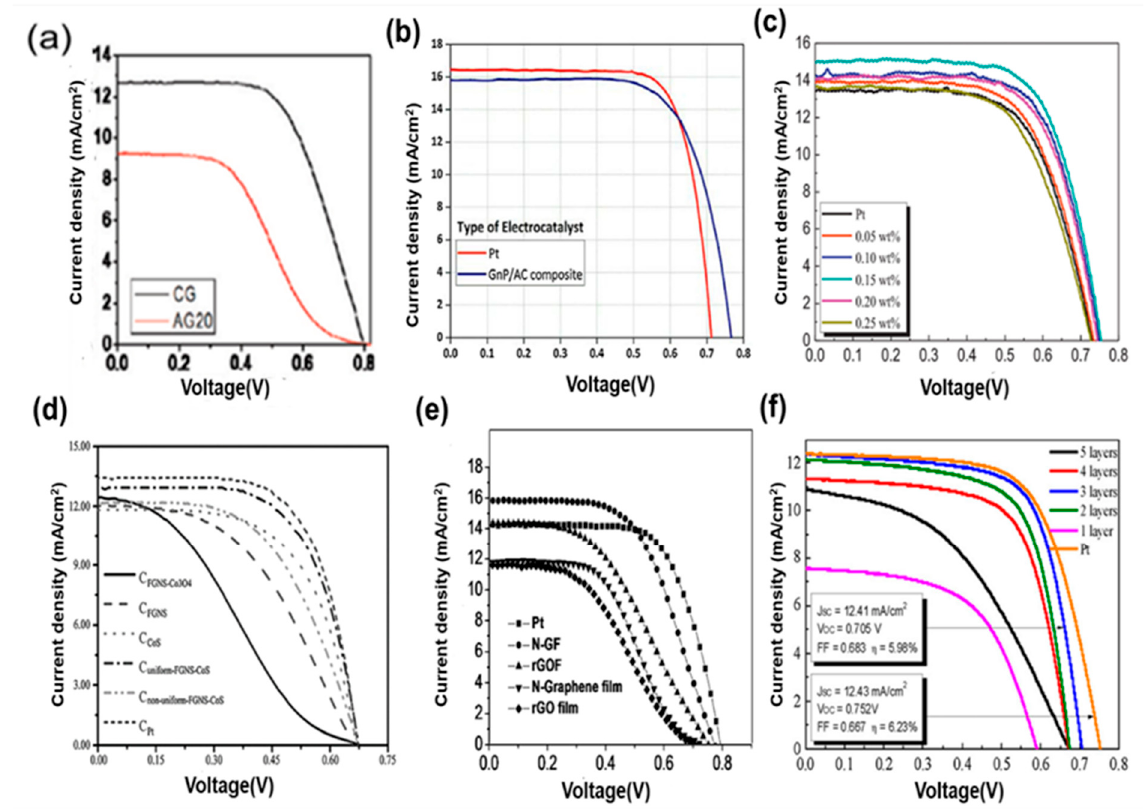
Figure 20. J–V curve of hybrid graphene materials: ( a ) graphite and A20 graphite, ( b ) graphite / activated carbon. Reprinted with permission from Reference [58]. ( c ) Gr + Pt. Reprinted with permission